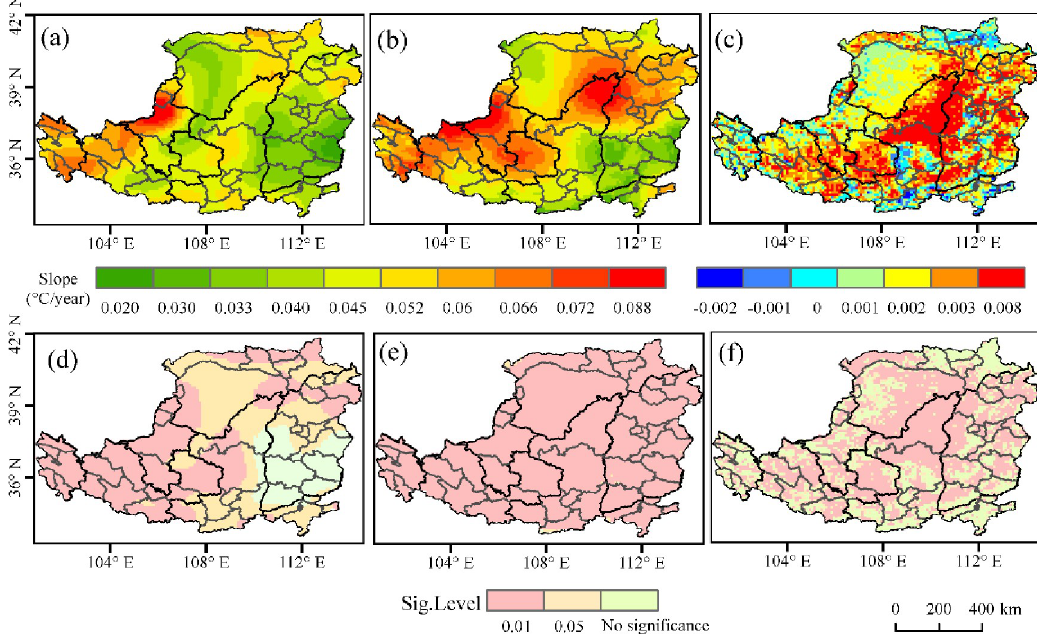
Fig 3. Trends of T max / T min and NDVI in summer over the Loess Plateau from 1982 to 2015. (a) the slope of T max; (b) the slope ; (c) the slope of NDVI; (d) the significance level of T of T min significance level of NDVI